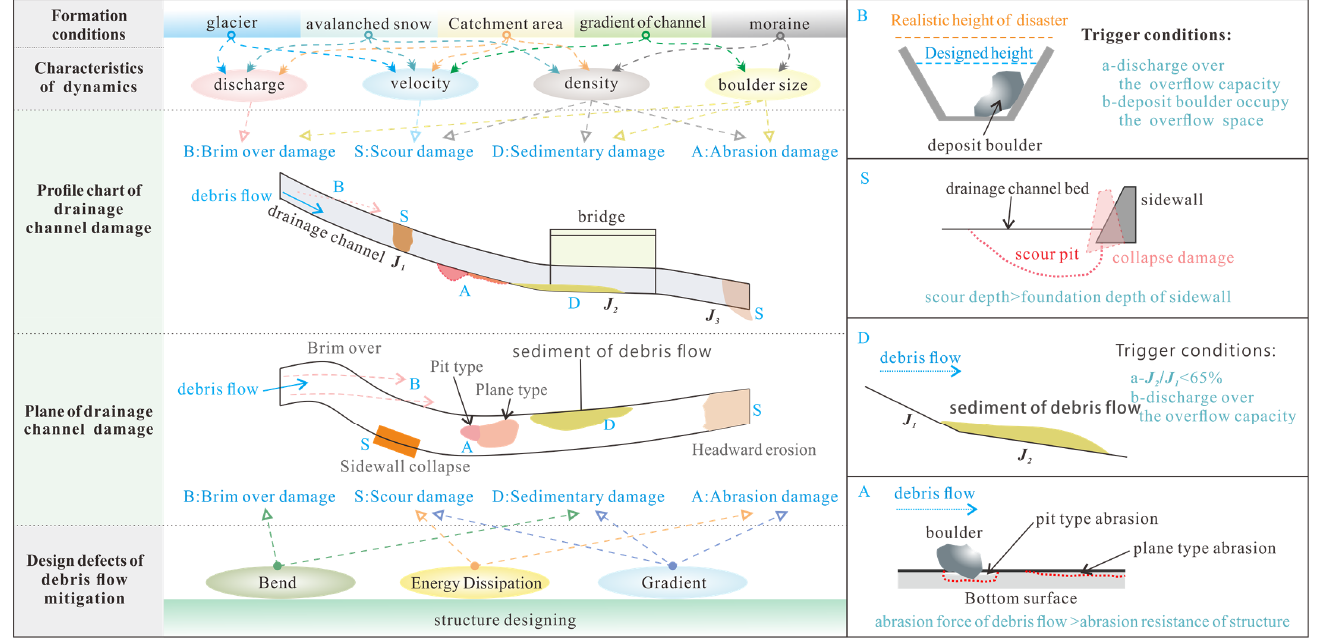
Figure 12. The damage models of drainage channels under glacial debris flow.